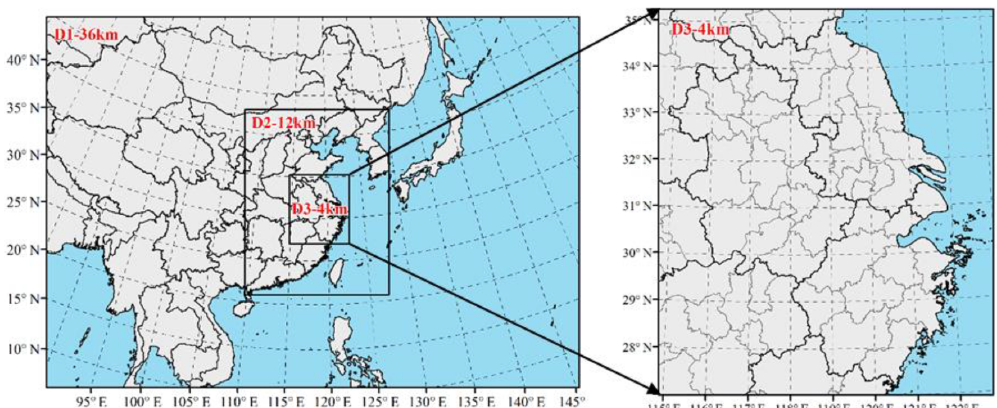
Figure 2. CAMx model